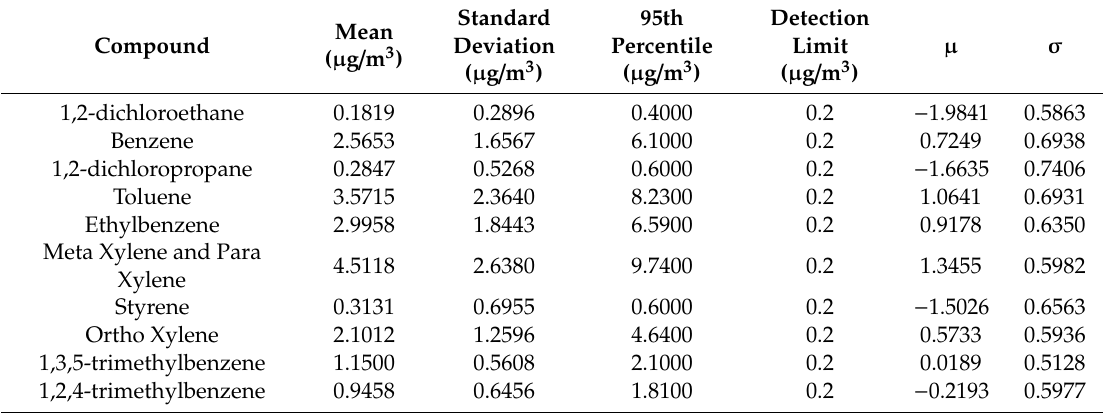
Table 6. Probability distribution parameters of the measured